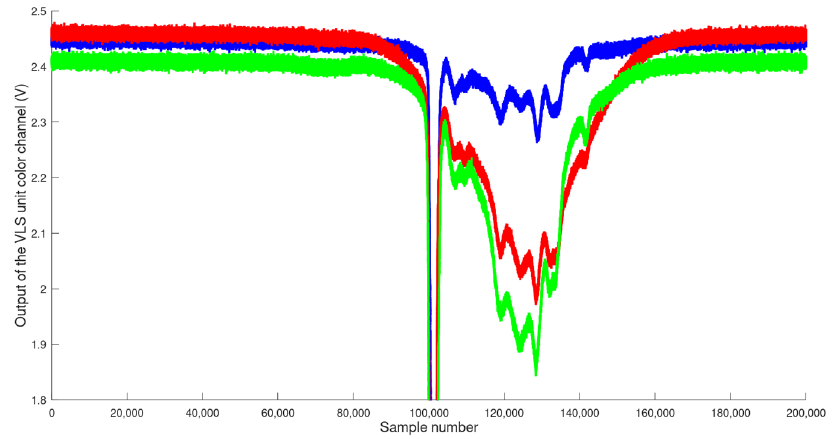
Figure 6. Output of the VLS unit color channels (V) in the scenario of 3M green Area 4 Speed 3 moving in the Forward direction.